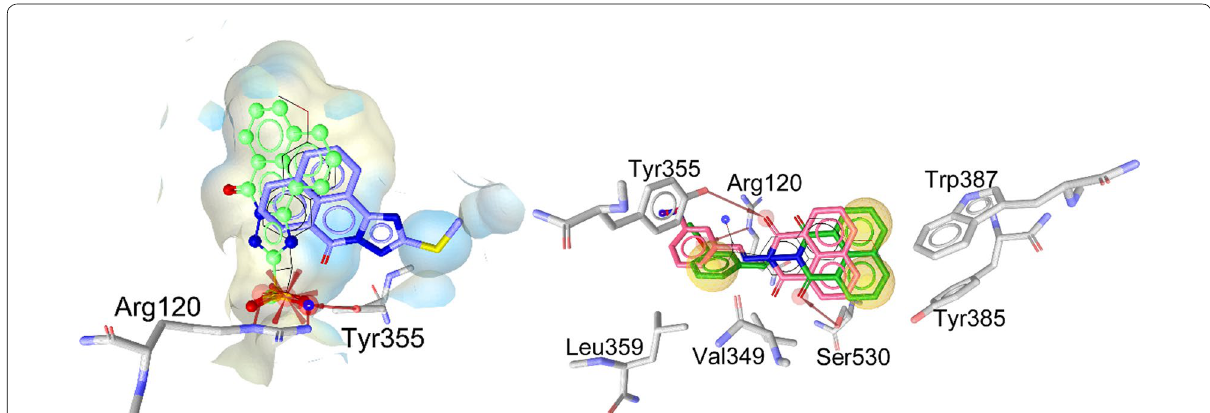
Fig. 7 Left: predicted binding modes of 2 (blue sticks), and 3 (green balls and sticks) superimposed with original conformation of naproxen (black lines) inside the COX‑2 active site (PDB entry: 3NT1). Red arrows represent hydrogen bonds. Right: suggested binding modes for 9 (green sticks) superposed with the original conformation of naproxen (black lines) inside the COX‑2 active site (PDB entry: